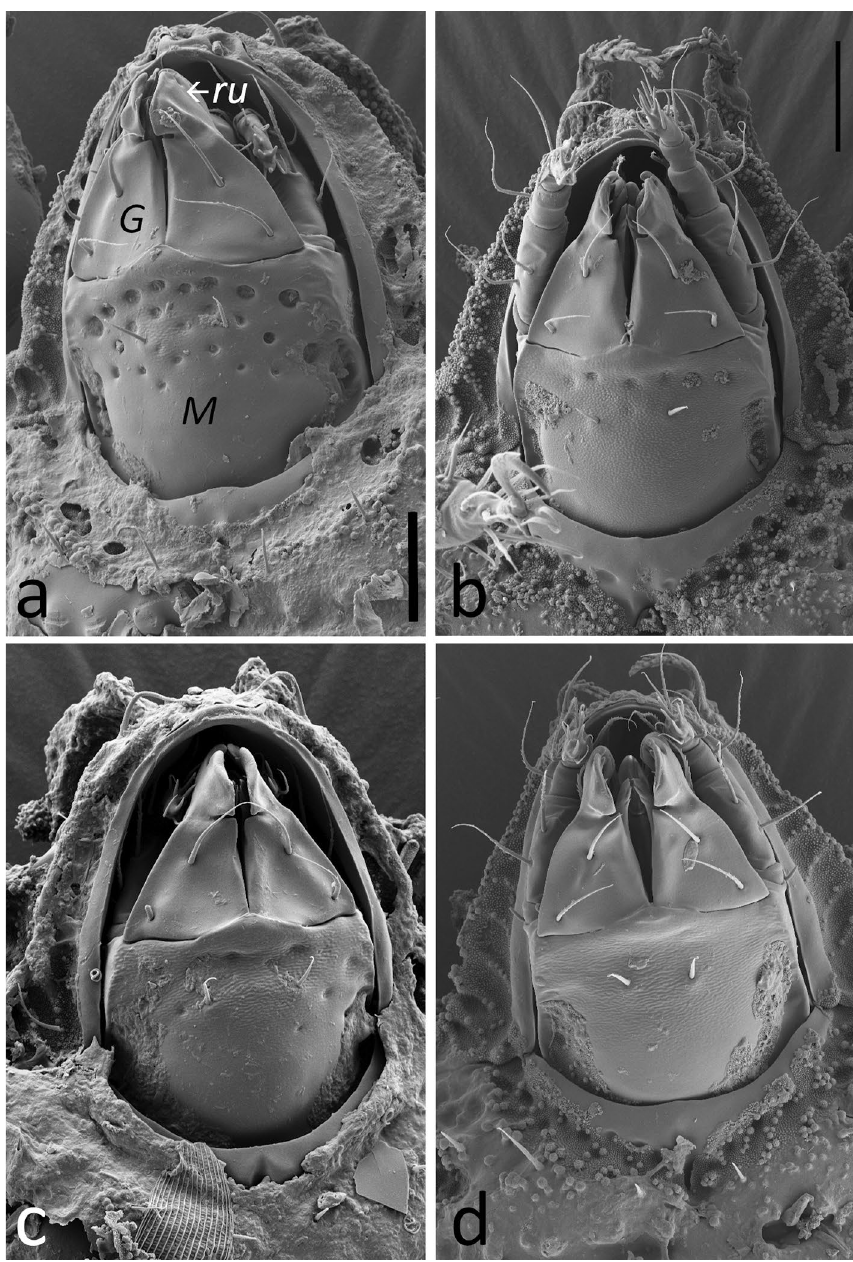
Figure 6. SEM micrographs of the distribution of foveae on mentum. ( a ) Caleremaeus mentobellus , ( b ) C. lignophilus , ( c ) C. alpinus , ( d ) C. hispanicus ; M = mentum, G = gena, ru = rutellum. Scale bar = 20